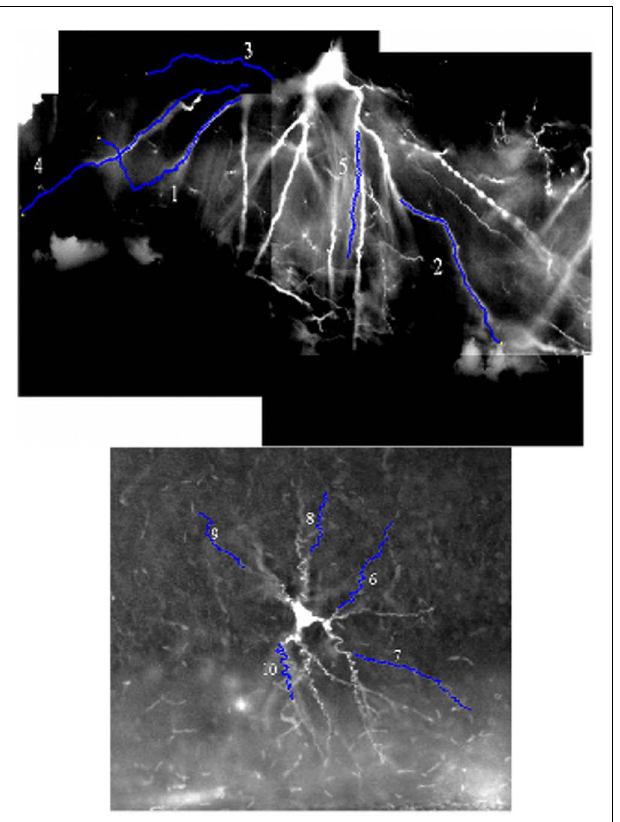
FIGURE 4 |An example image from both benchmark image stacks, with the position of the ten benchmark dendrites marked upon them. The luminosity is inverted in both cases (the stacks are naturally dark dendrites on a light background), and the luminosity histogram has been stretched to improve the contrast with the